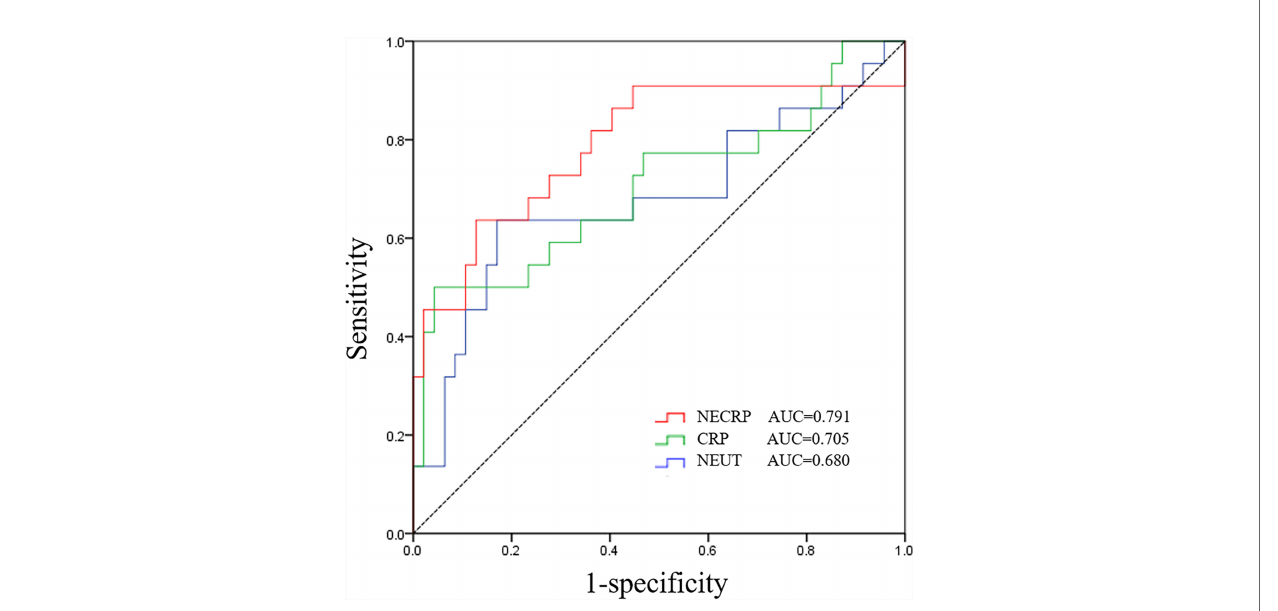
FIGURE 6 | Combined model, neutrophil and C-reactive protein for predicting 30-day in CRKP-CRAB